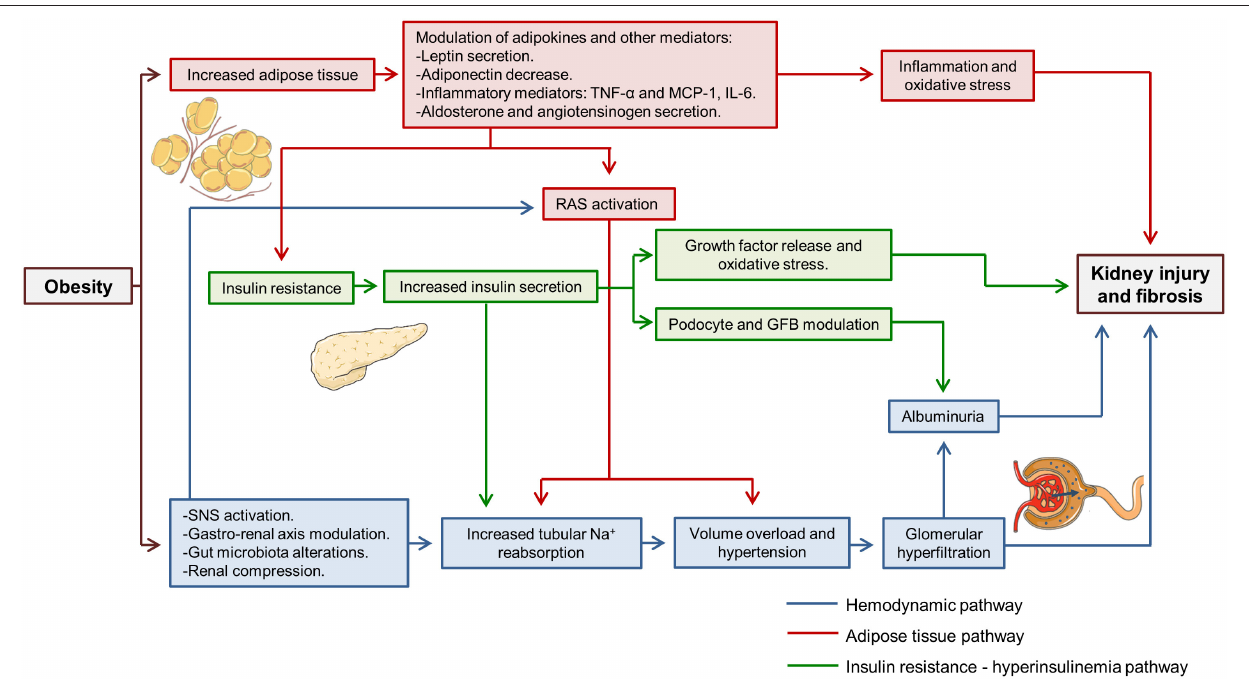
FIGURE 1 | Pathways involved in obesity-related kidney disease. Three main pathways involved (hemodynamic, adipose tissue related and insulin resistance—hyperinsulinemia pathways) have been highlighted in different colors. It can be observed how three pathways interact simultaneously to produce kidney injury. TNF- α , tumor necrosis factor α ; MCP-1, monocyte chemoattractant protein 1; IL-6, interleukine 6; RAS, renin-angiotensin system; GFB, glomerular filtration barrier; SNS, sympathetic nervous system; Na + ,